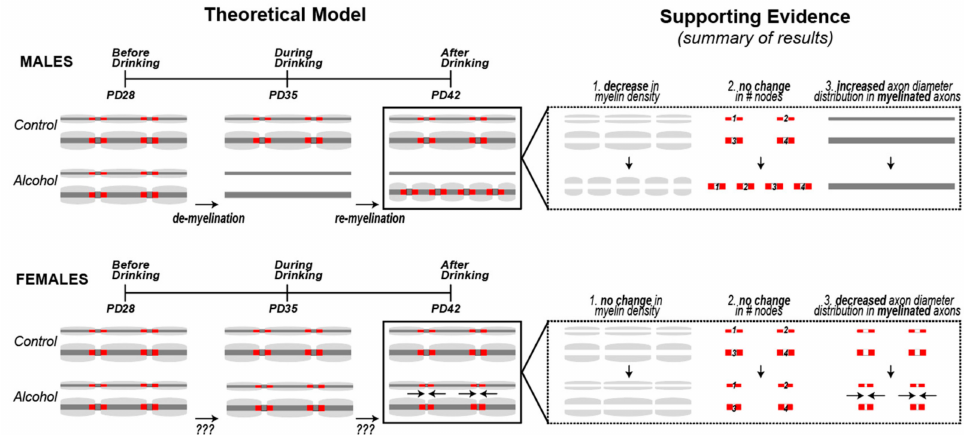
Figure 5. Theoretical Model Supported by Results Summary. We propose a model where alcohol causes demyelination, followed by the initiation of remyelination of axons in the Cg1 of males. Three pieces of evidence support this demyelination + remyelination hypothesis in males: (1) a decrease in overall myelin density, coupled with (2) no change in the number of nodes, and (3) a shift in the distribution towards myelinated axons with larger diameters. All three results are consistent with having thinner and shorter myelin sheaths, which is a staple of remyelination [45,46]. We did not observe the same phenomenon in females, suggesting a less robust e ff ect of alcohol on myelin in females, or possibly a more e ff ective remyelination process that returns the myelinated fiber density levels back to normal by the end of the alcohol exposure